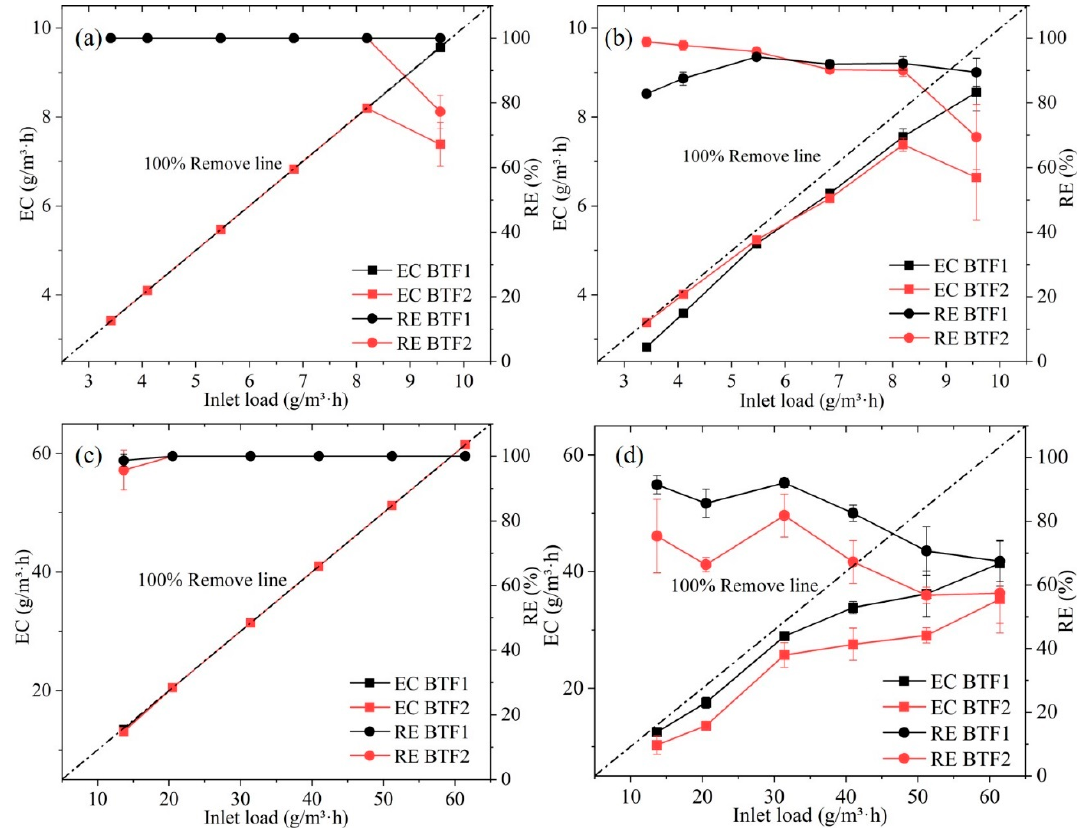
Figure 5. The elimination capacity of different EBRT ( a , b ) and inlet concentrations ( c , d ) for H 2 S ( a , c ) and NH 3 ( b , d ).